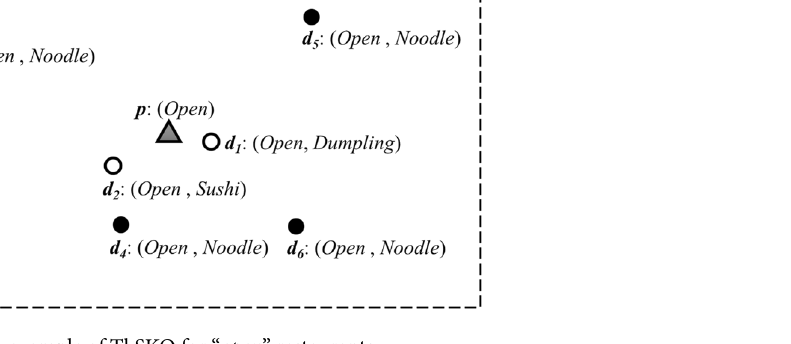
Figure 1. An example of TkSKQ for “ open ”